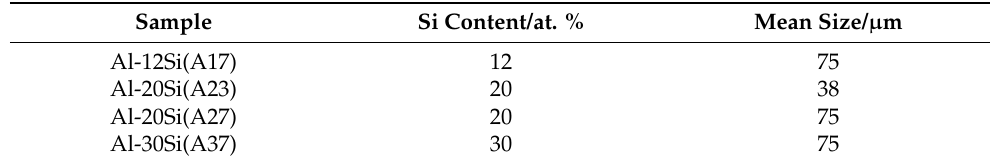
Table 1. Parameters of the Al-Si powders. Sample Si Content/at.